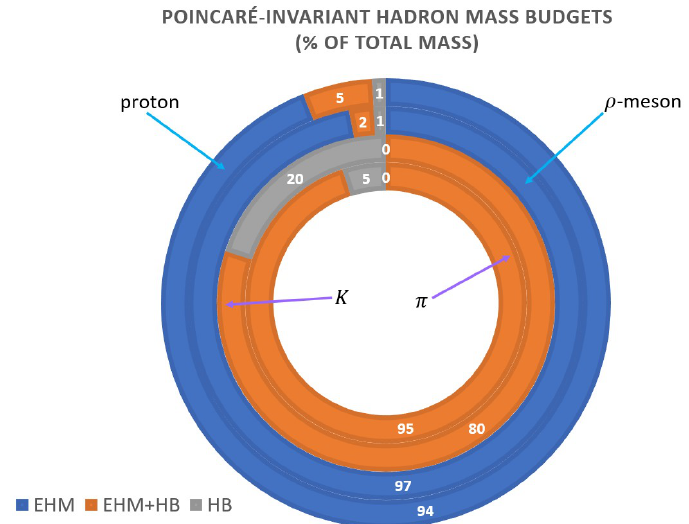
Figure 4. Mass budgets for the proton (outermost annulus), ρ -meson, kaon, and pion (innermost annulus). Each annulus is drawn using a Poincaré-invariant decomposition. The separation is made at a renormalization scale ζ = 2GeV, calculated using information from References